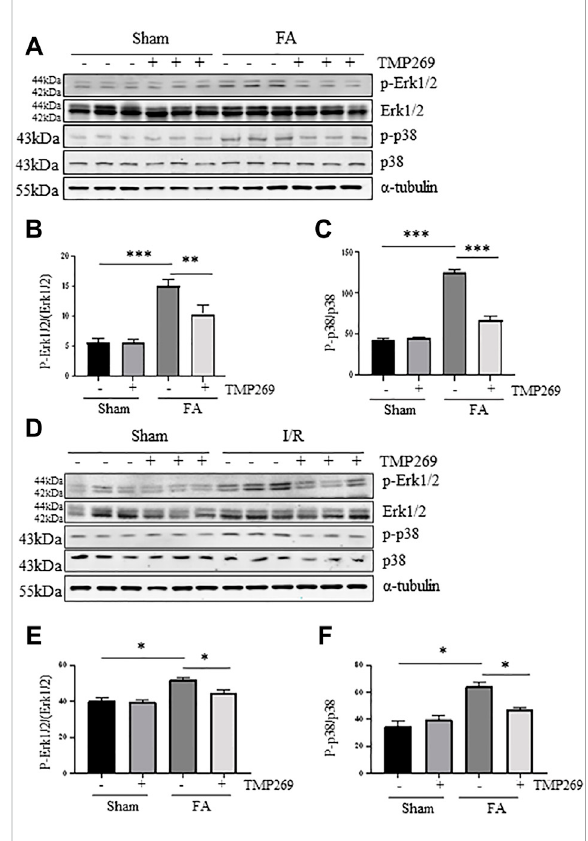
FIGURE 8 Administration of TMP269 inhibits MAPK signaling pathways (A,D) Kidneys were injured by FA or IR, respectively, and tissue lysates were subjected to immunoblot analysis with speci fi c antibodiesagainstp-ERK1/2,ERK1/2,p-p38,p38or α -tubulin. Representative immunoblots are three samples in each group. Expression levels of p-ERK1/2 (B,E) and p-38 (C,F) were quanti fi ed by densitometry and normalized with ERK1/2 and